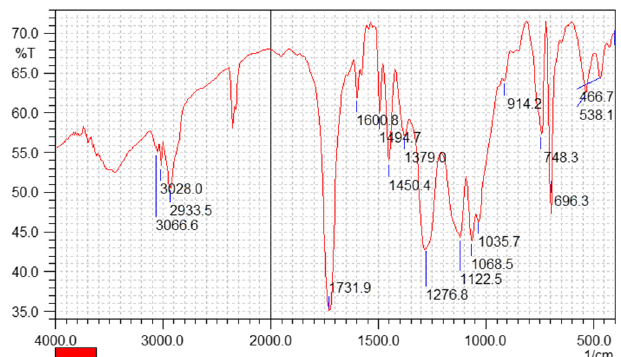
Figure 5. Spectrum of HCl attack residue from marble (the solvent was HCl).